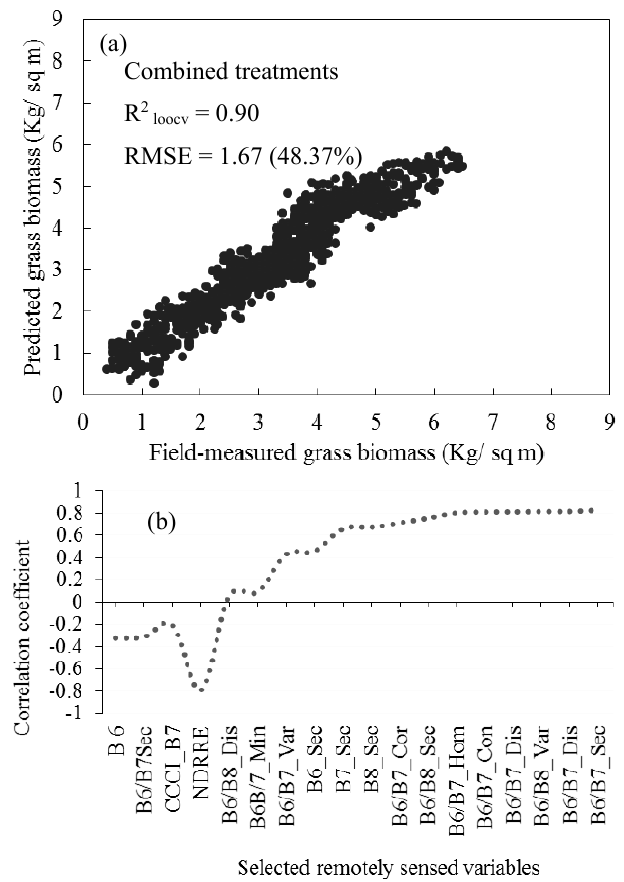
Figure 5. ( a ) Relationship between the field-measured and estimated grass above-ground biomass across all grass management treatments for validating sparse partial least regression (SPLSR) models, based on the leave-one-out cross-validation procedure. Note that the relative root mean square error is presented as a percentage; ( b ) illustrates the relationship between all the optimal variables and grass biomass across all treatments.